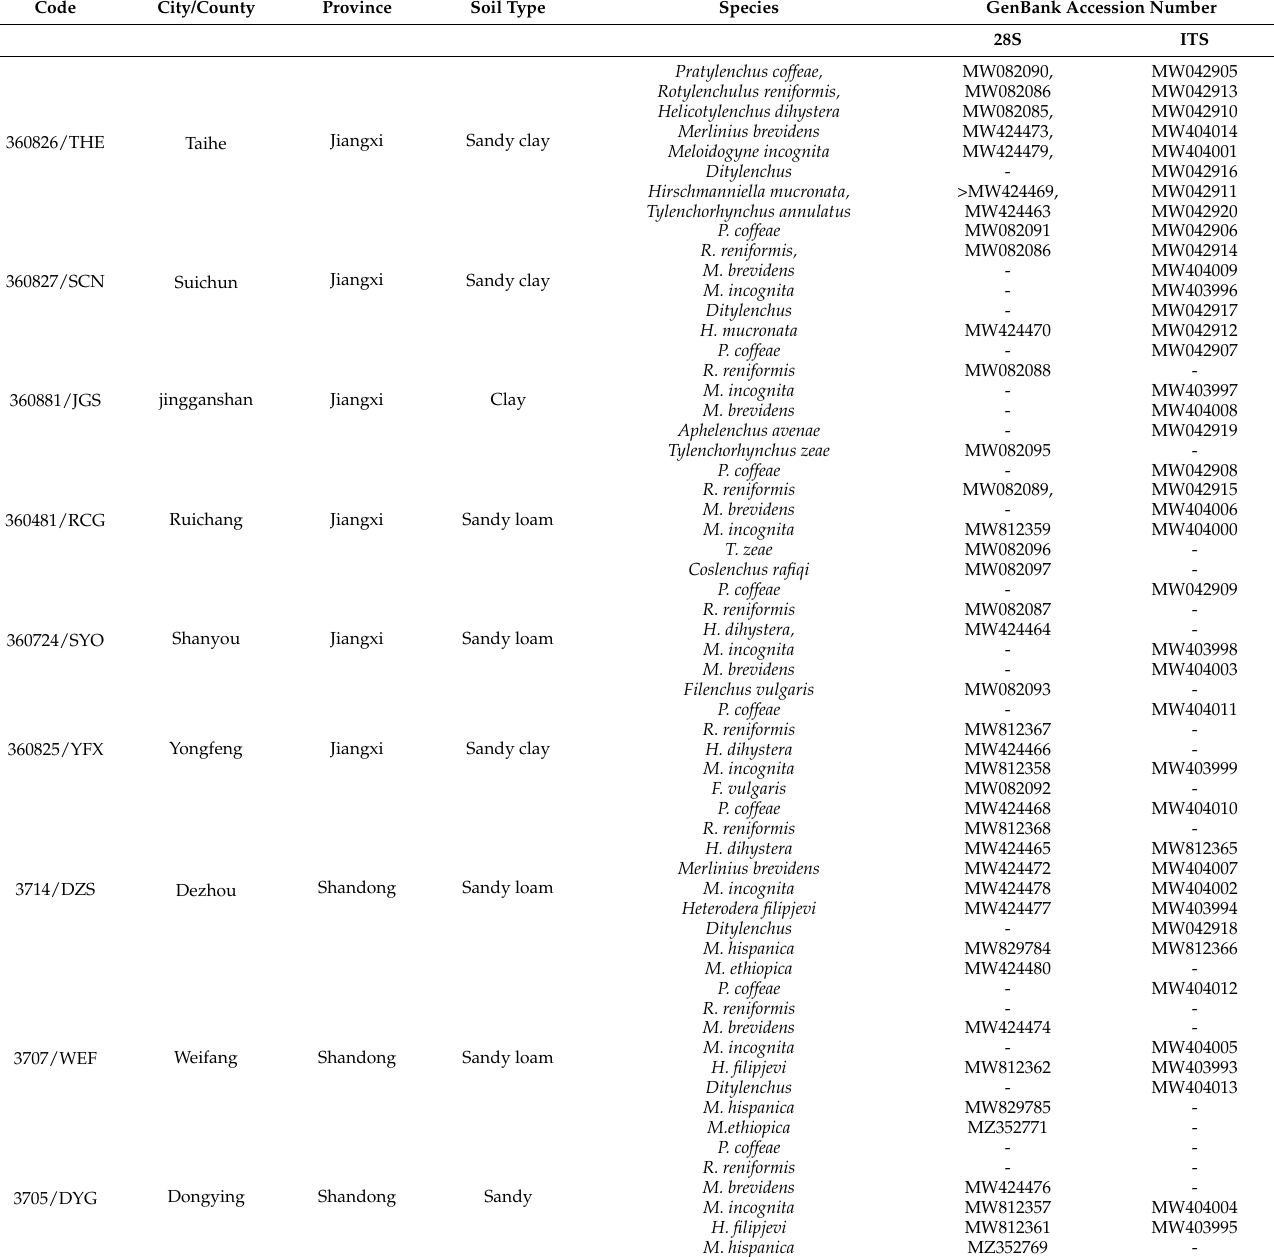
Table 1. Plant-parasitic nematodes species on yam collected in south-east China provinces (Jiangxi and Shandong), soil type characterization, and respective GenBank accession number from 28S and ITS